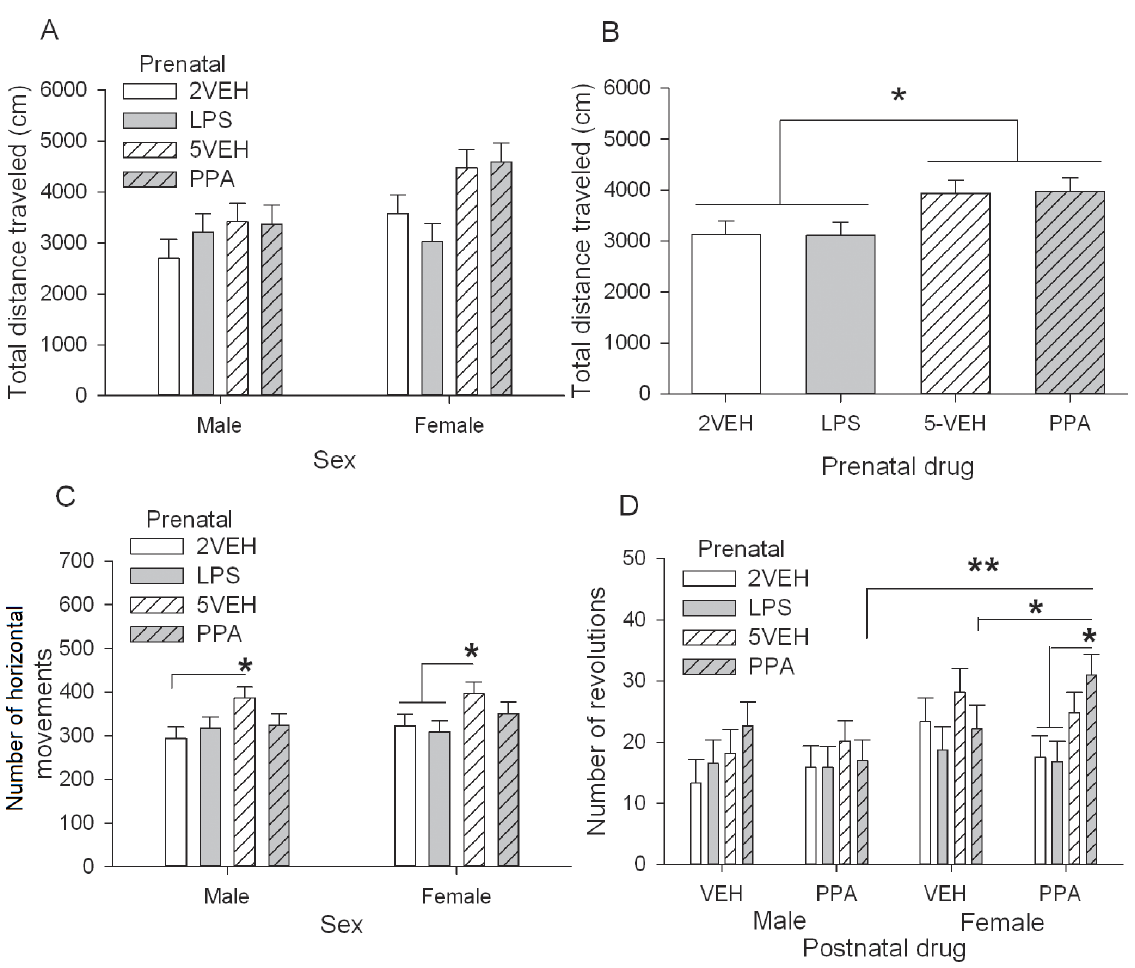
Figure 4. Locomotor activity in a novel open-field (P42) in male and female offspring. Adolescent females moved significantly more than males. A–B Total distance traveled (cm). Prenatal PPA and 5VEH treated animals moved significantly more than prenatal LPS and 2VEH treated animals, regardless of sex. C: Number of horizontal movements. An effect of prenatal drug showed animals in the prenatal 5VEH group made significantly more horizontal movements than the other 3 prenatal treatment groups. D: Number of revolutions. Females made significantly more revolutions than males. A double hit of prenatal PPA and postnatal PPA produced significantly more revolutions in female offspring compared to prenatal PPA alone in females and a double hit of PPA in males. Error bars represent S.E.M. Refer to Table 1 for group designations and sample sizes. * p , 0.05, ** p , 0.01. vertical movements than prenatal PPA treated males, p = 0.001 (Figure 5D). No significant effects of prenatal treatments (LPS or (Figure 5C) and a significant main effect of Prenatal drug, F (3,100) = 2.82, p =0.043, for horizontal movement time in the PPA) were found for vertical time (Figure S4F). centre (Figure S4E). Animals in the prenatal PPA group traveled Overall, prenatal LPS and postnatal PPA did not significantly significantly greater total distances than all other prenatal groups alter time spent, or locomotor activity, in the perimeter or centre (5VEH p , 0.001, LPS p = 0.006, 2VEH p =0.008). This effect was of the open-field. However, prenatal PPA significantly decreased present in both females (prenatal PPA significantly greater than time spent, and increased locomotor activity, in the centre of the other 3 groups, p s , 0.01) and in males (prenatal PPA significantly open-field in both males and females. greater than 5VEH, p = 0.021). For horizontal movement time, Elevated Plus Maze. The number of entries into the closed prenatal PPA treated animals spent significantly more time arm was used as a measure of locomotion. There were no moving in the centre than 5VEH treated animals, p =0.005. (Figure 6A). Number of entries into the open arm, percent time spent in the open arm, and closed arm time were used as traditional measures of anxiety-like behavior. For number of entries into the open arm, there was a Prenatal drug 6 Postnatal drug interaction, F (3,92) =2.99, p =0.035. Post- natal PPA treated animals in the prenatal 5VEH group entered the open arm significantly fewer times than postnatal VEH